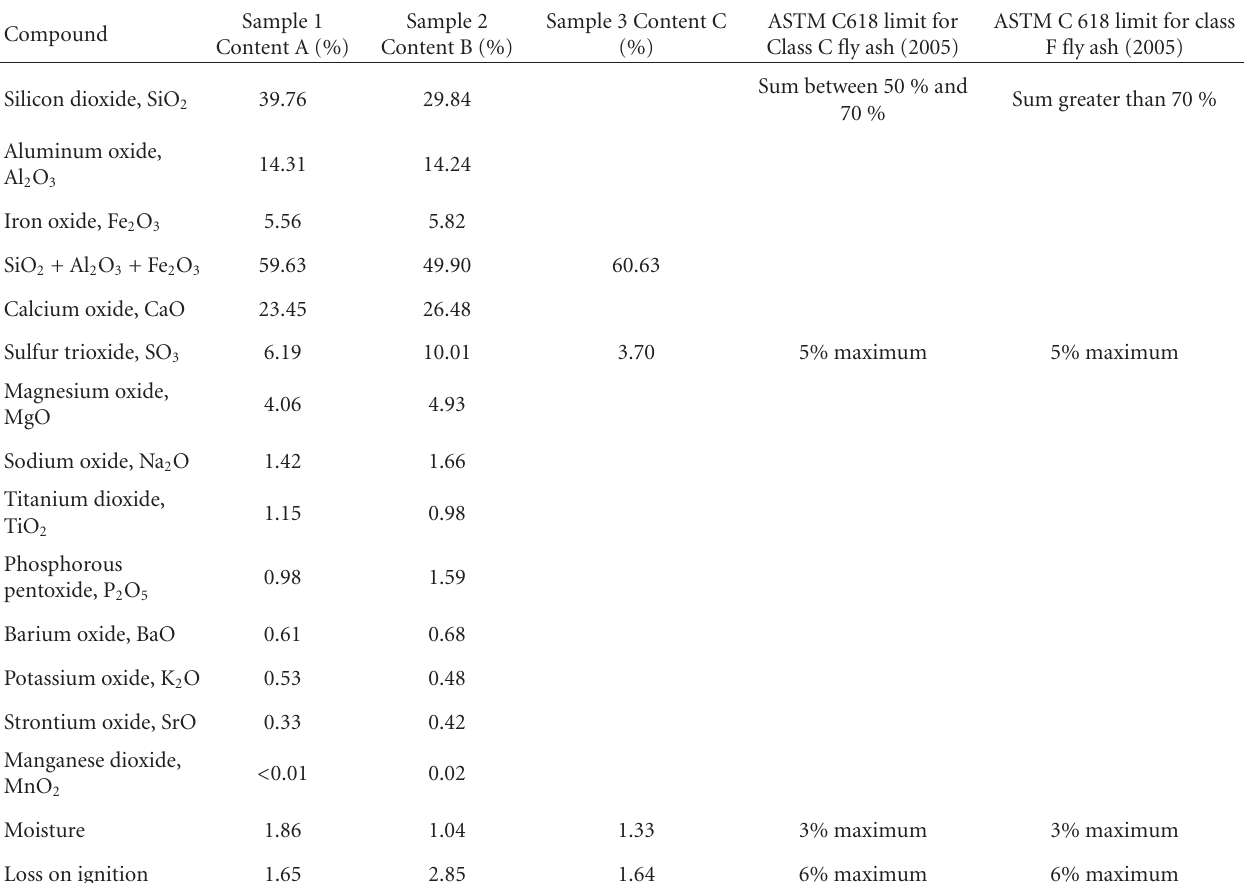
Table 1: Bulk chemical composition of rawhide power station